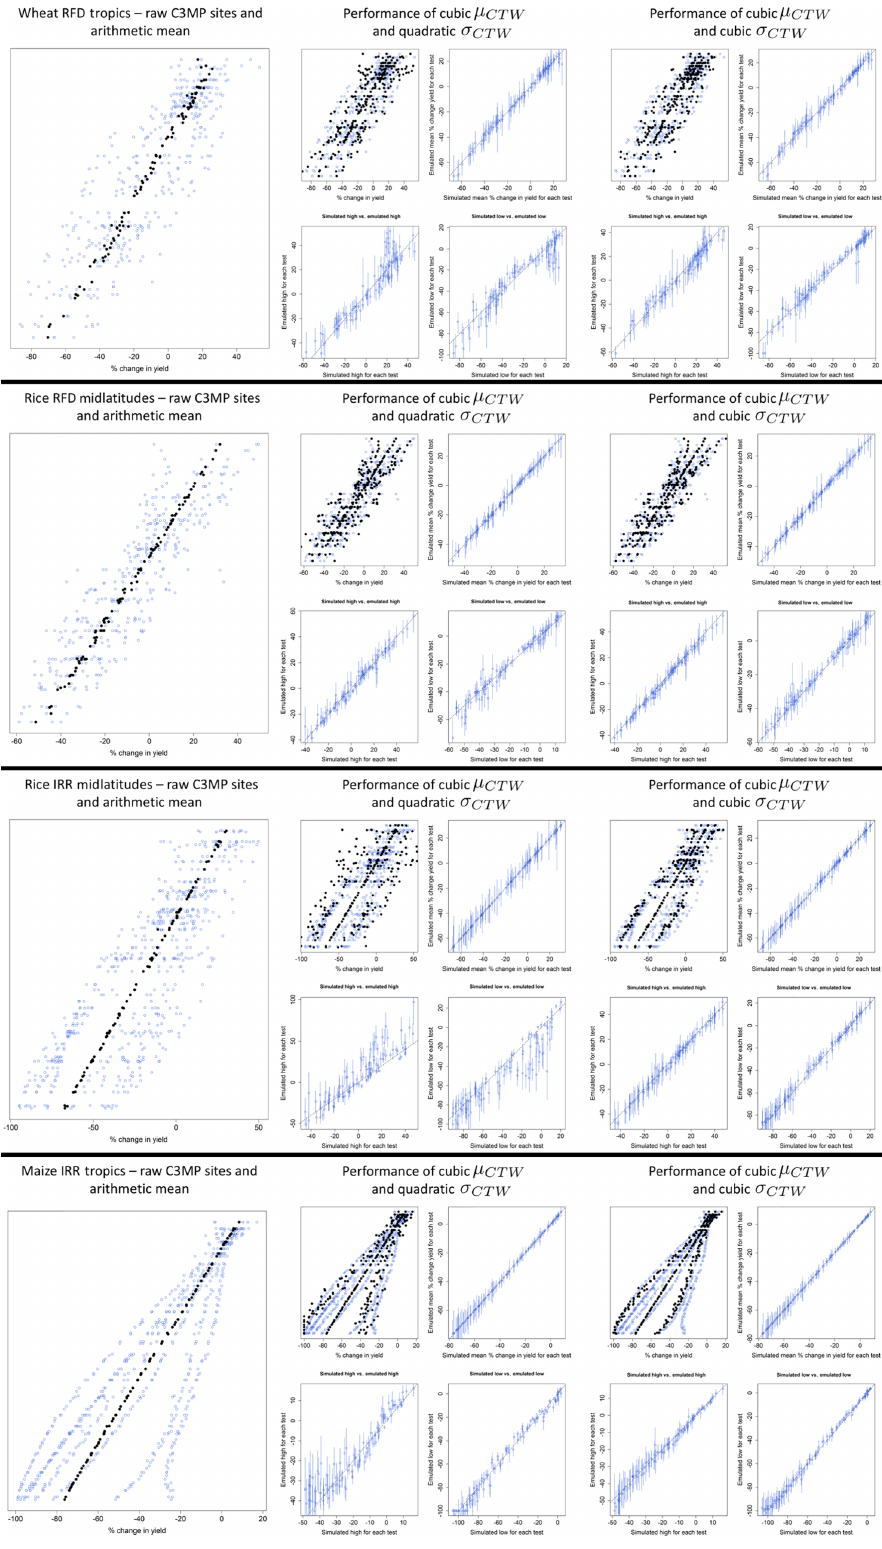
Figure 7. The same arrangement of figures as in Fig. 6, for the rain-fed wheat in the extended tropics (top row), rain-fed rice in the mid- latitudes (second row), irrigated rice in the midlatitudes (third row), and irrigated maize in the extended tropics (bottom row) production